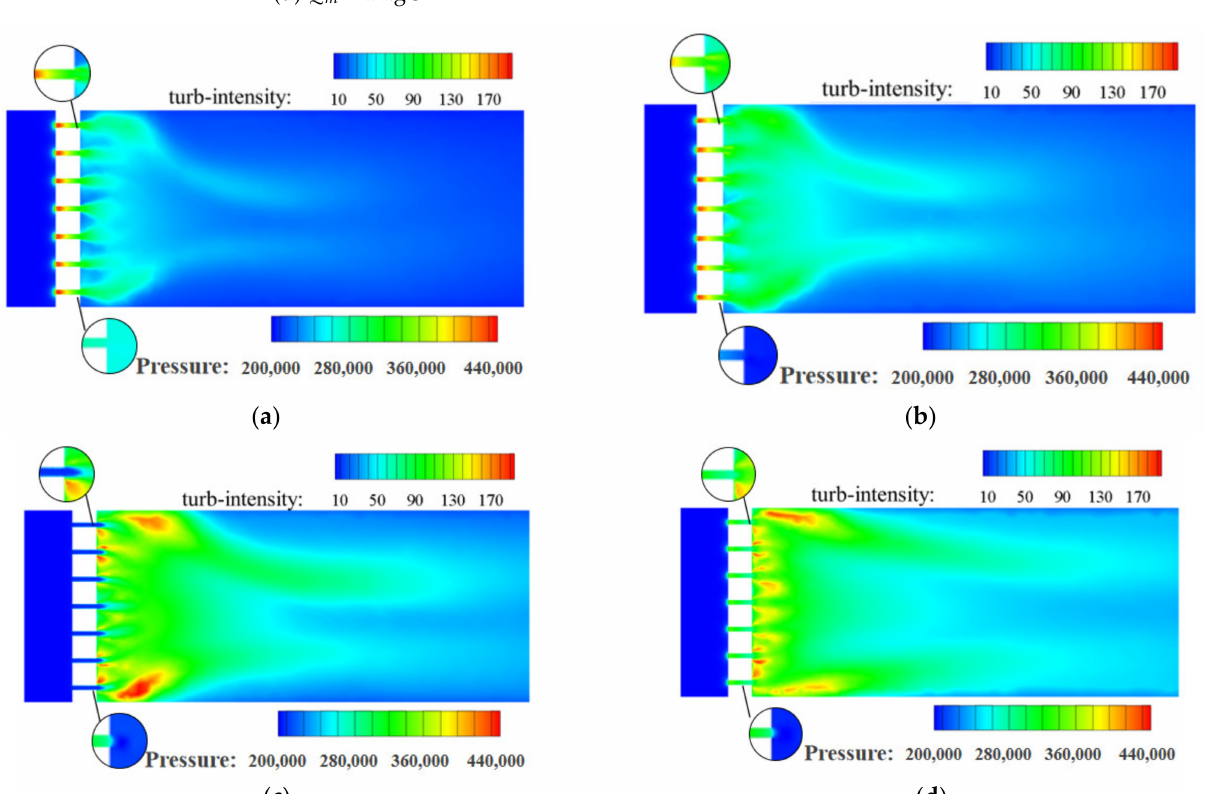
Figure 11. Turbulence intensity distribution on the symmetry plane for the conventional orifice plate structure under different mass flow rates (%). ( a ) Q m = 0.02 kg s − 1 . ( b ) Q m = 0.1 kg s − 1 . ( c ) Q m = 0.5 kg s − 1 . ( d ) Q m = 1 kg s − 1